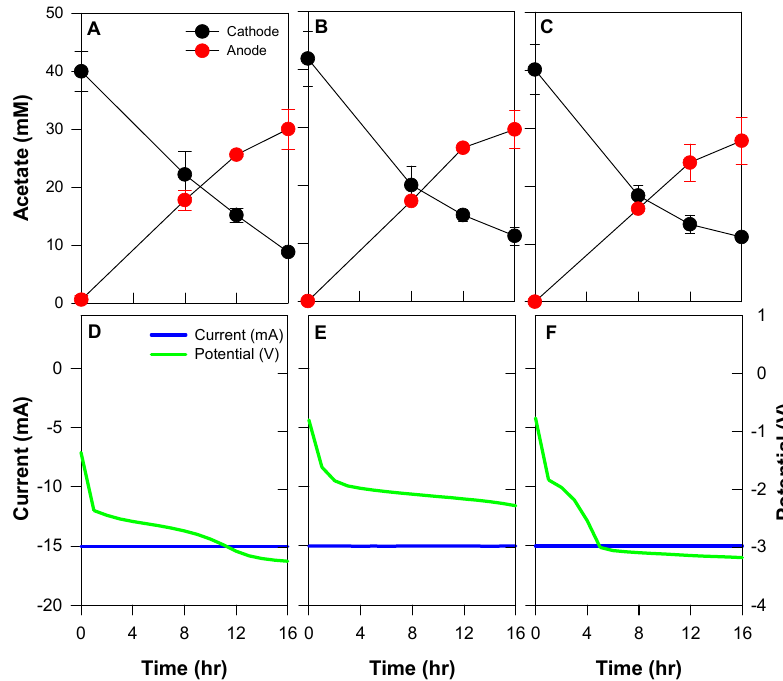
Figure 4. Changes in the acetate concentration by electrodialysis when the initial pH of the anode was varied. Initial anode pH 2.0 ( A , D ); pH 4.0 ( B , E ); pH 6.0 ( C , F ).